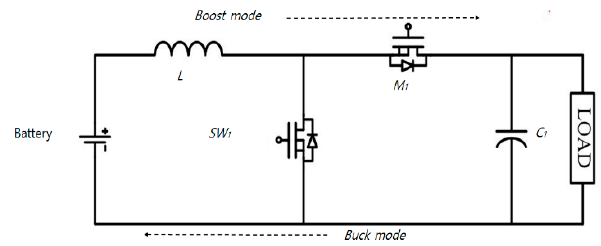
Figure 4. Synchronous bidirectional boost